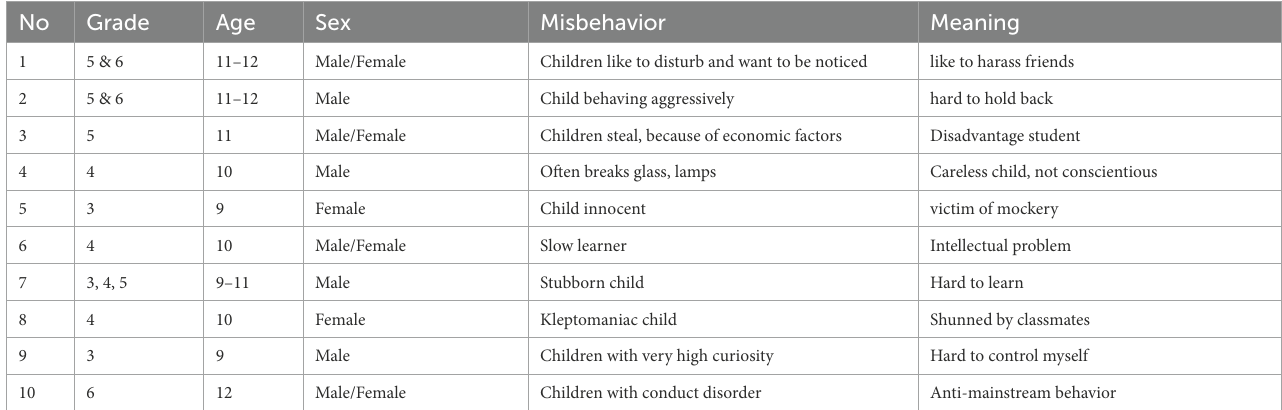
TABLE 3 Type of students who have the adjustment problems.